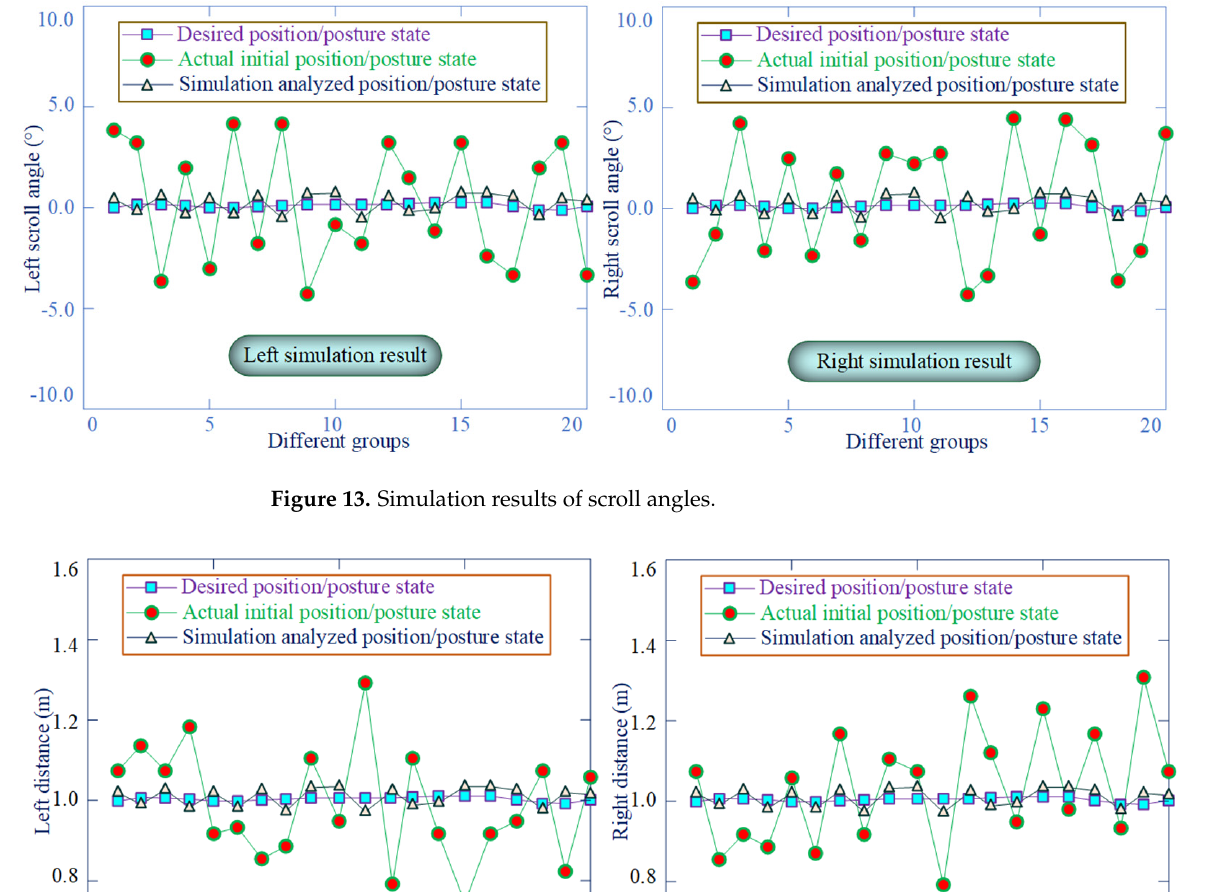
Figure 12. Simulation results of declination angles.